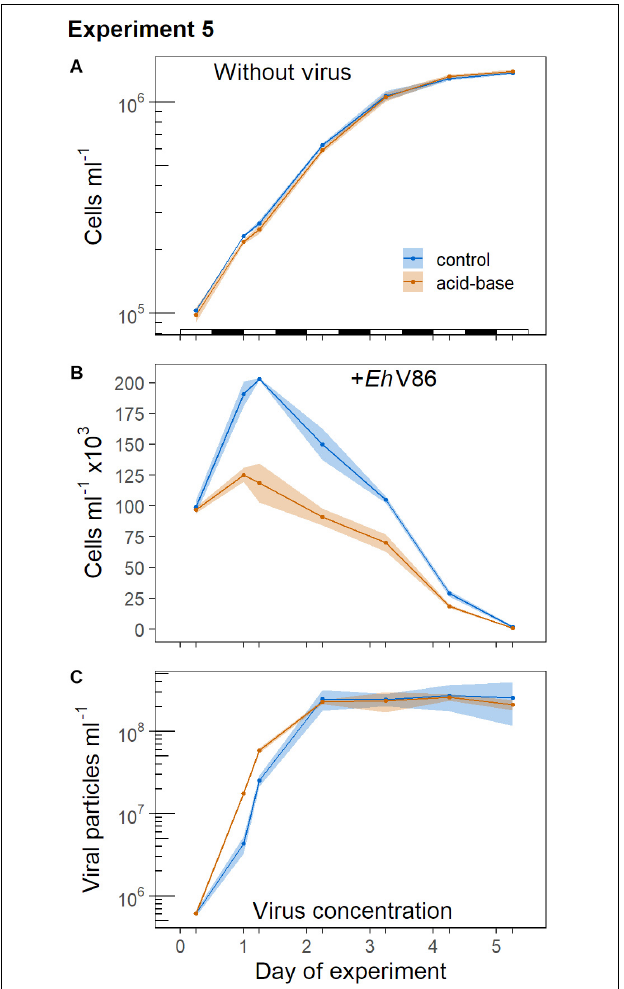
FIGURE 7 | Virus addition to calcified and decalcified cells in the middle of the light period, subsequent to the acid-base treatment. Sample means and 95% CI ( n = 3). (A) Concentration of calcifying E. huxleyi CCMP1516 without virus and when virus was added (B) ; (C) concentration of viral particles. The alteration of the light and dark phases is indicated in (A) .